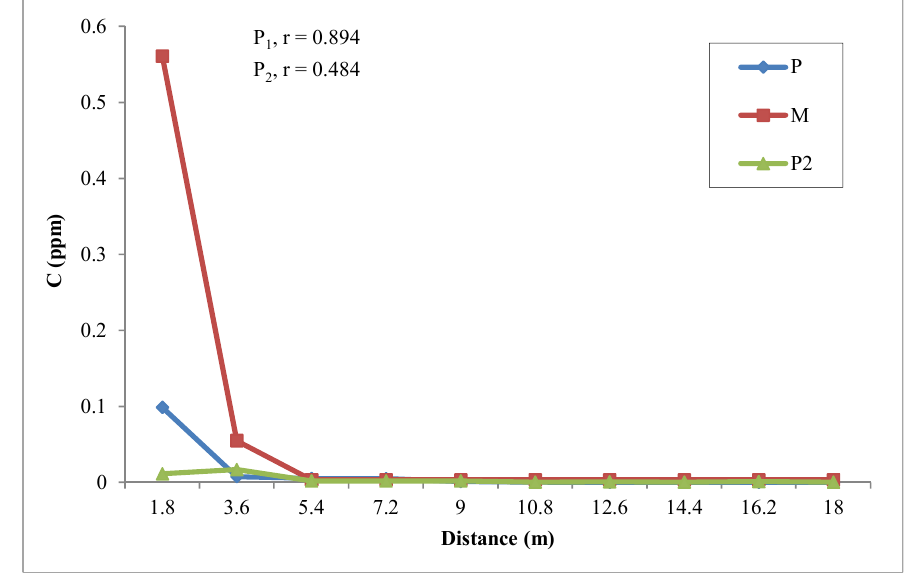
Figure 4. Measured and Predicted Concentrations against Distance for the month of